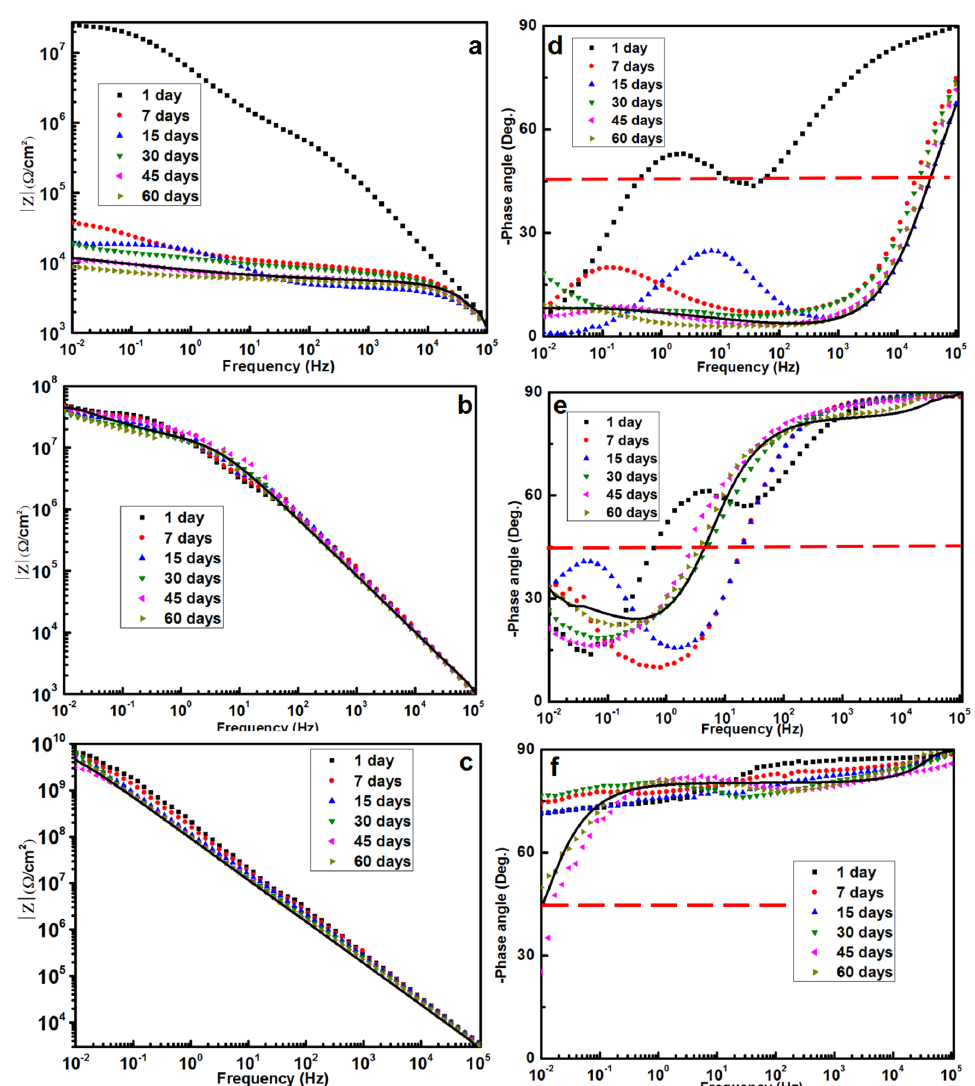
Figure 5. Bode plots of ( a , d ) pure epoxy coating, ( b , e ) OTiO 2 (w) epoxy coating, and ( c , f ) iETiO 2 (w) epoxy